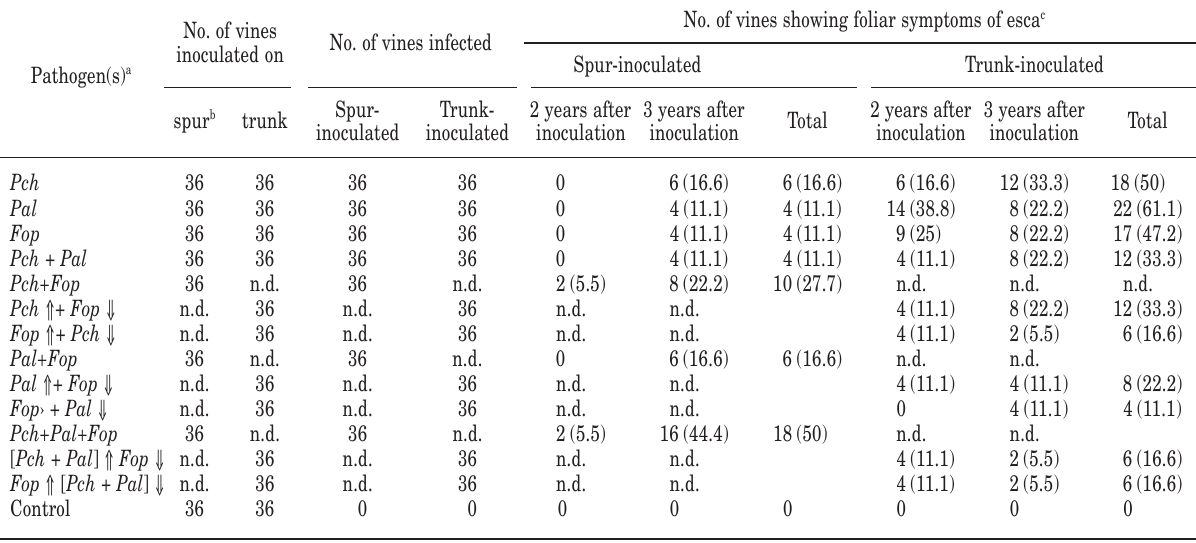
Fig. 1. Mean length of the brown streaks in the spurs (left) or stems and branches (right) of grapevine cv. Italia ( ) and Matilde ( ) inoculated with Phaeomoniella chlamydospora ( Pch ), Phaeoacremonium aleophilum ( Pal ) and Fomitiporia punctata ( Fop ) alone or in combinations, at the end of the survey period (1999–2001). Stand- ard error bars are shown. For dual or triple inoculations, each fungus was inoculated above ( ⇑ ) or below ( ⇓ ) the inoculation site of the other(s). Table 1. Inoculation of grapevines cv. Italia with Phaeomoniella chlamydospora ( Pch ), Phaeoacremonium aleophilum ( Pal ) and Fomitiporia punctata ( Fop ) after two and three